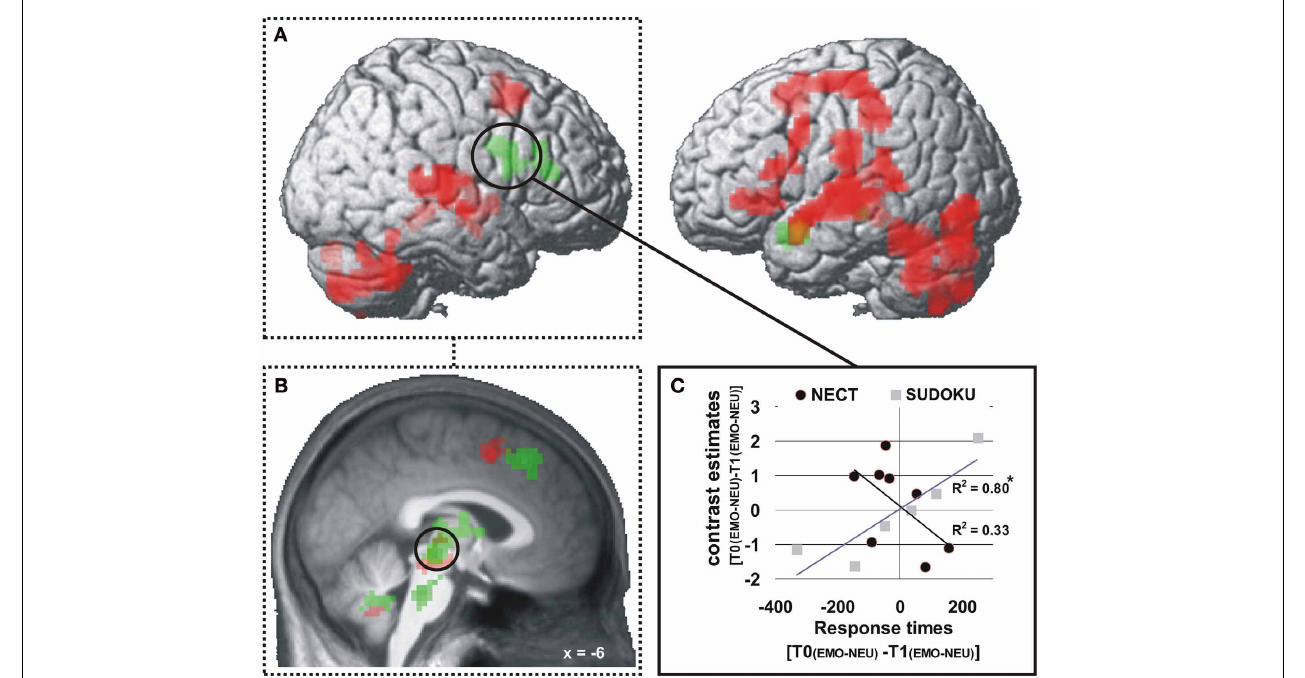
FIGURE 4 | Brain regions with training (NECT vs. SUDOKU) specific associations between changes in response times and cerebral responses (A,B). p < 0 . 001 (A) , p < 0 . 01 (B) , uncorrected, k ≥ 20 voxels (A) . A significant negative association of changes in behavioral emotion-sensitivity (as measured by the response times contrast: T0[EMO − NEU] − T1[EMO − NEU]; nota bene: due to generally longer